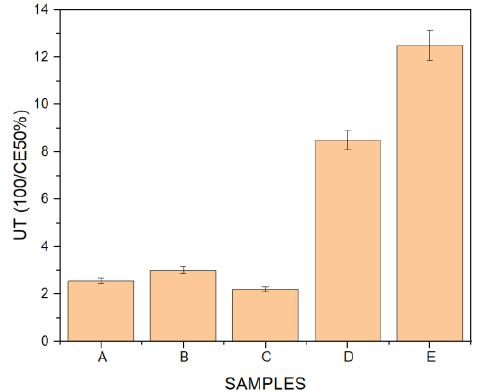
Figure 4. Results of acute toxicity tests (in toxicity units, TU= 100/EC50%) to D. similis before and after anodic oxidation for samples ( A ) mixture of progestogens (LNG + GES) without electrochemical processing and in the absence of NaCl; ( B ) mixture of progestogens (LNG + GES) without electrochemical processing in the presence of NaCl; ( C ) NaCl solution without electrochemical processing; ( D ) NaCl solution after electrochemical processing (20 min); and ( E ) mixture of progestogens (LNG + GES) after electrochemical processing (20 min) in the presence of NaCl ([LNG] 0 = [GES] 0 = 1.0 mg L −1 ; j = 32.5 mA cm −2 ; [NaCl] 0 = 0.07 mol L −1 ). Values correspond to an average of eight replicates.